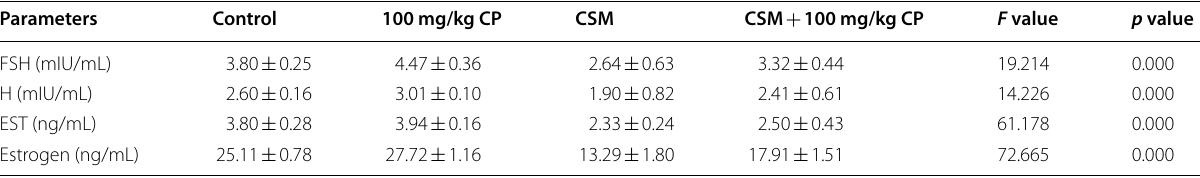
Values are mean standard deviation (mean standard deviation) and level of statistical significance considered at p < 0.05. Where FSH follicle stimulating hormones, ± LH luteinizing hormones, TEST testosterone, CP Cissus populnea, CSM cotton seed meal Table 2 Effect of aqueous Cissus populnea suspension on antioxidant status in male Wistar rats